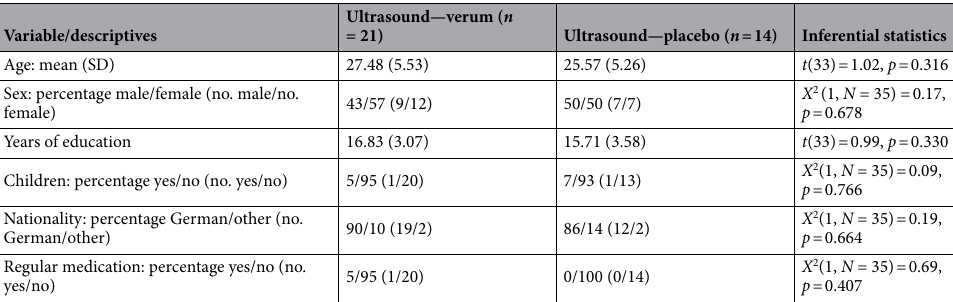
Table 1. Descriptive sample data and between-group differences for socio-demographic variables.